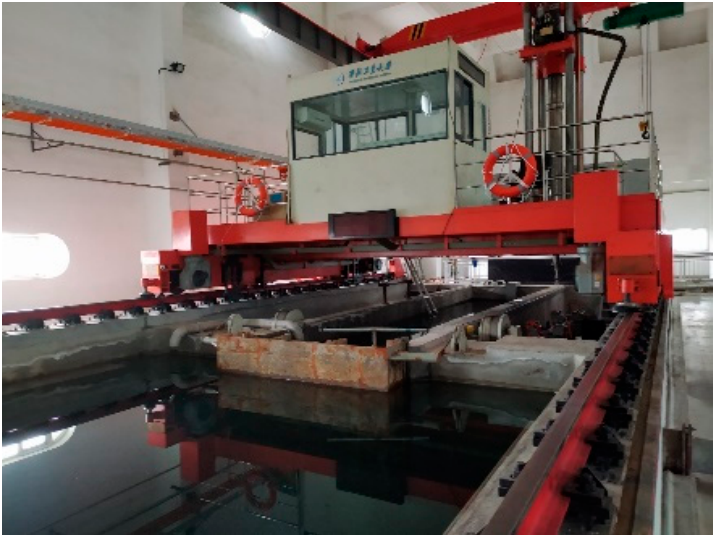
Figure 10. Towing system for the Unmanned Underwater Delivery Technology Laboratory.